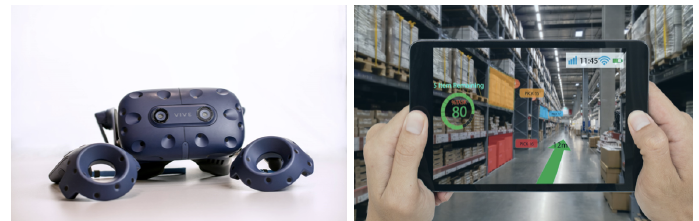
Figure 3. HTC Vive ( left ) and tablet with AR application ( right ).